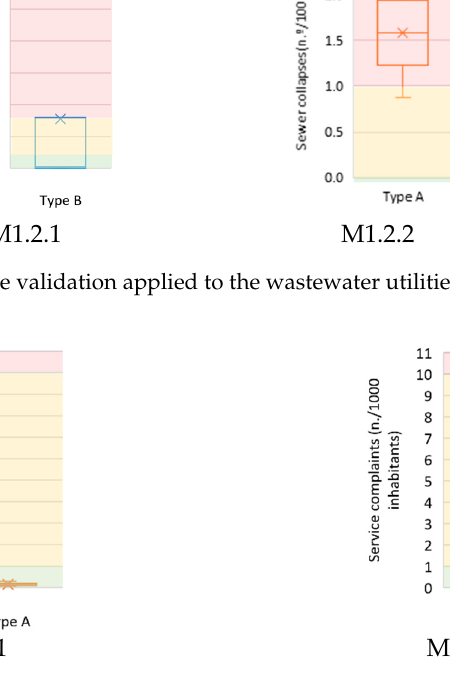
Figure 6. Results of the validation applied to the wastewater utilities: objective 2.